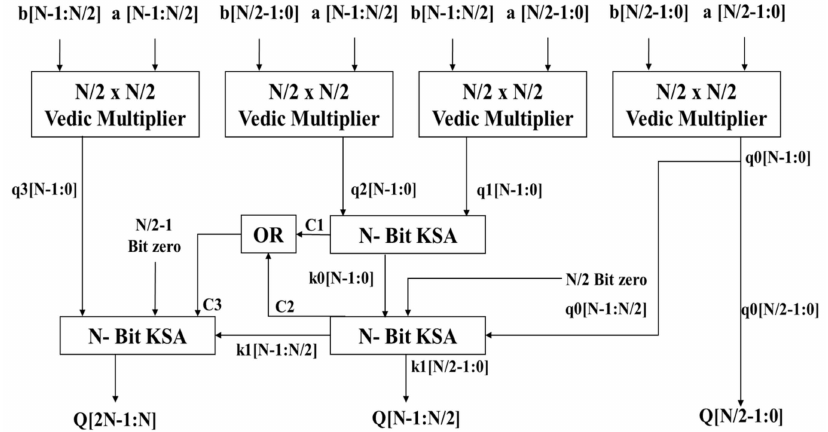
Figure 3. Block Diagram of Vedic multiplier using